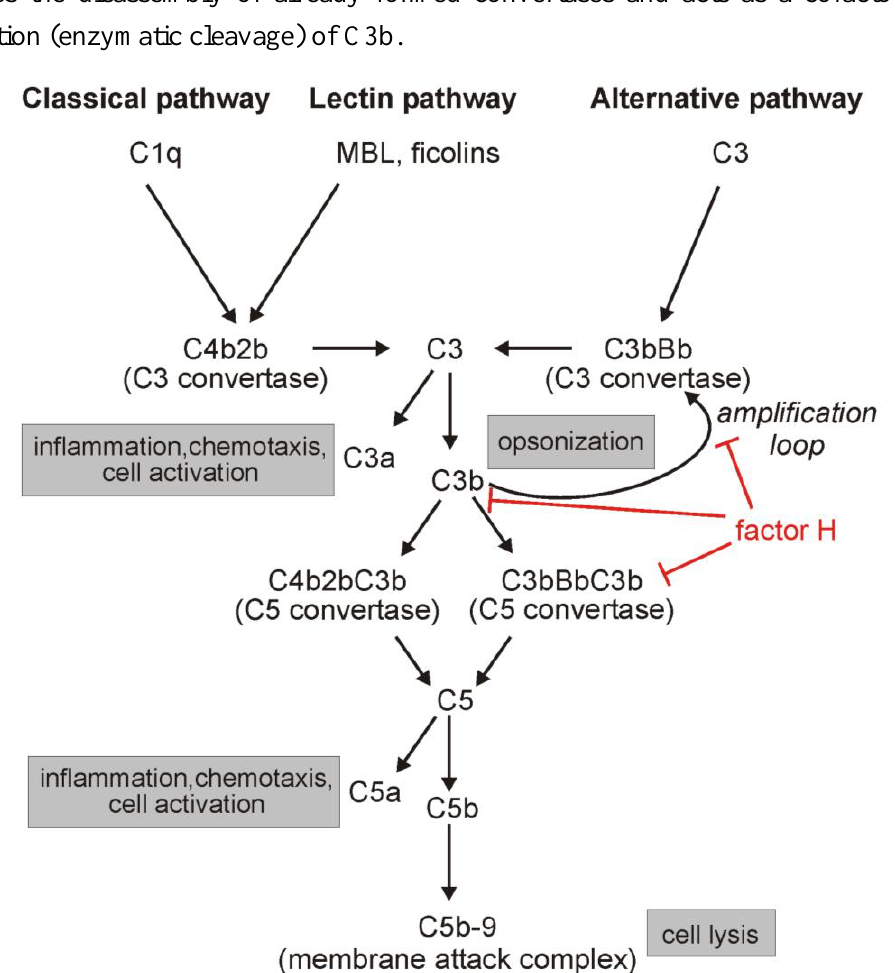
Figure 1. Complement activation pathways and the regulatory role of factor